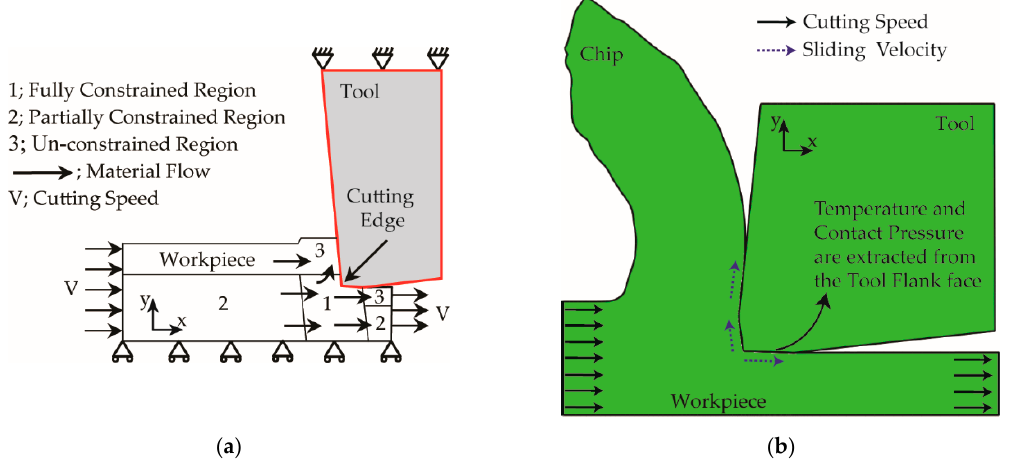
Figure 7. ( a ) Geometry and boundary conditions of orthogonal Arbitrary Lagrangian–Eulerian ( ALE) cutting models. ( b ) Chip formation in orthogonal ALE simulation: temperature, contact pressure, and sliding velocity at flank wear–workpiece interface.